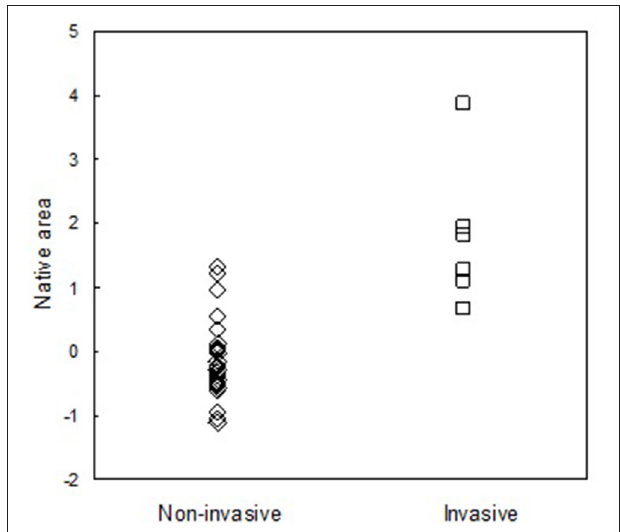
FIGURE 3 | The standardized areas of species of the genera Coccinella , Harmonia , Hippodamia , and Propylea that remained limited to their native areas in the Palearctic (non-invasive species) and seven species of these genera that spread after they invaded the Nearctic (invasive species).